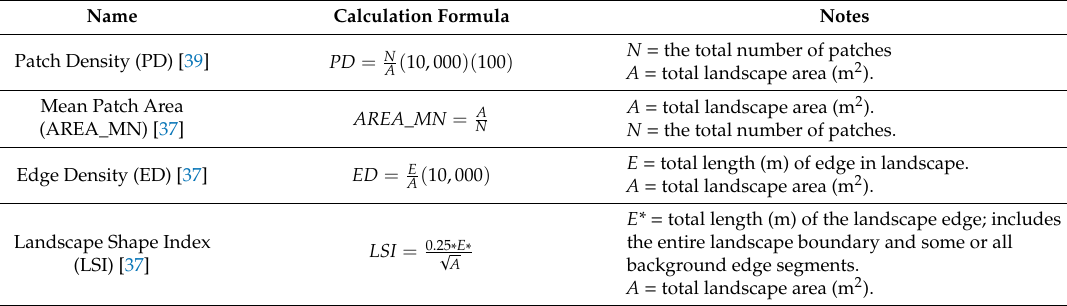
Table 3. Landscape pattern indexes used in this